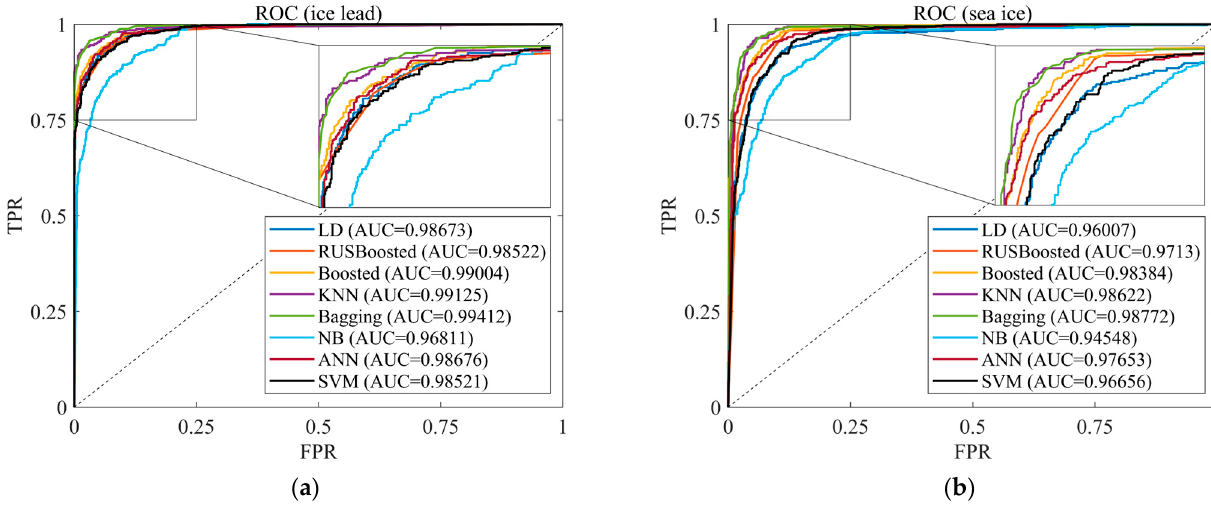
Figure 10. ROC curve and AUC of supervised classifier: ( a ) lead; ( b ) sea ice.